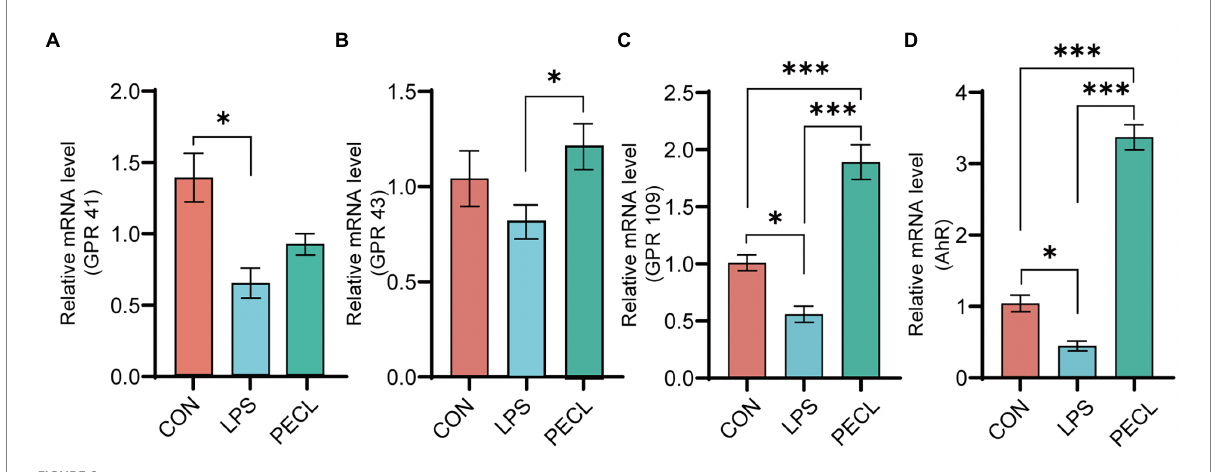
FIGURE 6 Relative mRNA expression of receptors in cecal mucosa. (A) GPR41, (B) GPR43, (C) GPR109, (D) AHR. Signification is presented as * p < 0.05, ** p < 0.01, and *** p < 0.001; data are presented as the mean ±